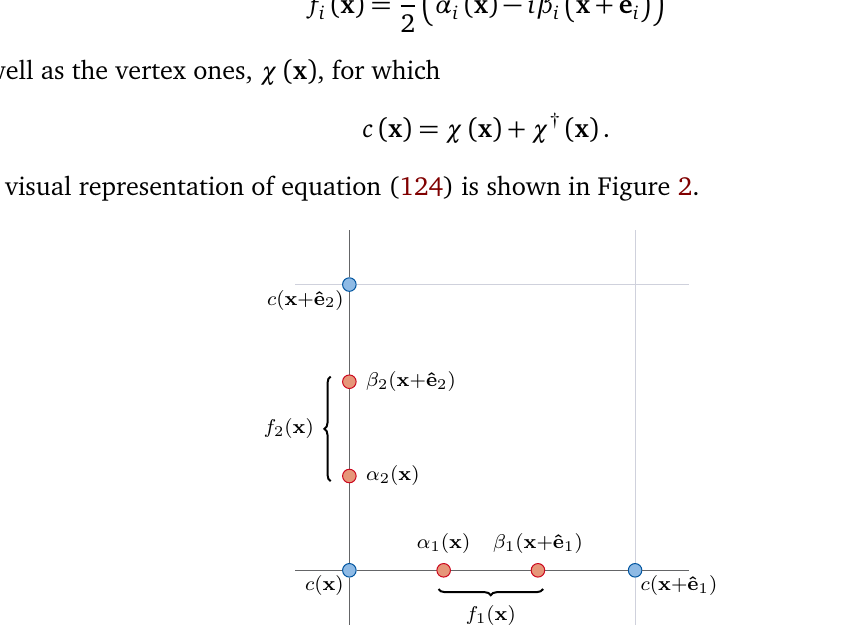
( x ) related to vertex x in i